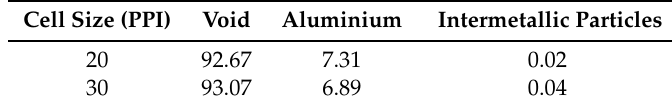
Table 2. Volume fractions in percent (%) of the different phases in the foam samples.